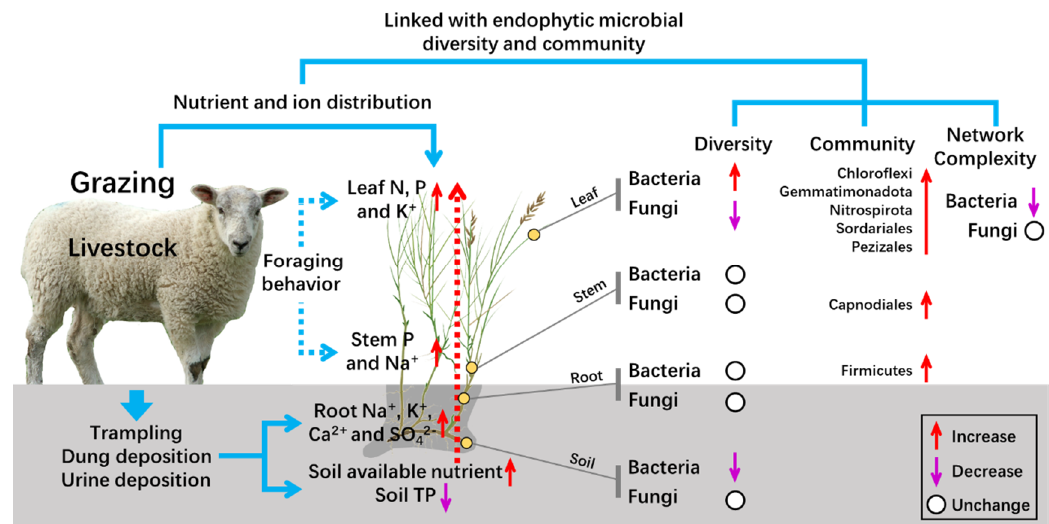
Figure 7. Conceptual framework for understanding the effect of long-term grazing on bacterial and fungal diversity and community in the rhizosphere and endosphere compartments of L. chinensis . Livestock grazing increases available soil nutrients, plant nutrients, and ion accumulation through forging behavior, trampling, and dung and urine deposition. The changed soil properties and plant characteristics shape bacterial and fungal communities in different compartments of the plant. Overall, the variation of microbial diversity and community composition in the rhizosphere and endosphere of L. chinensis can be attributed to grazing-induced changes in nutrient and ion distribution in the plant–soil system.